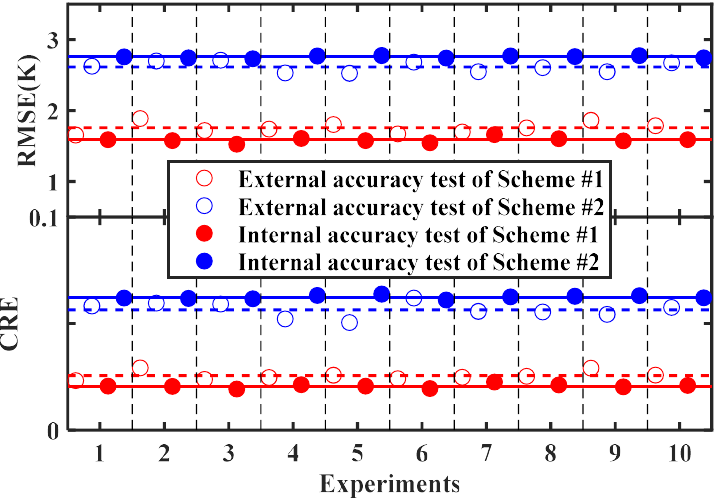
Figure 2. Scatter plots of the RMSE and CRE of the internal and external accuracy tests for different schemes in each experiment.